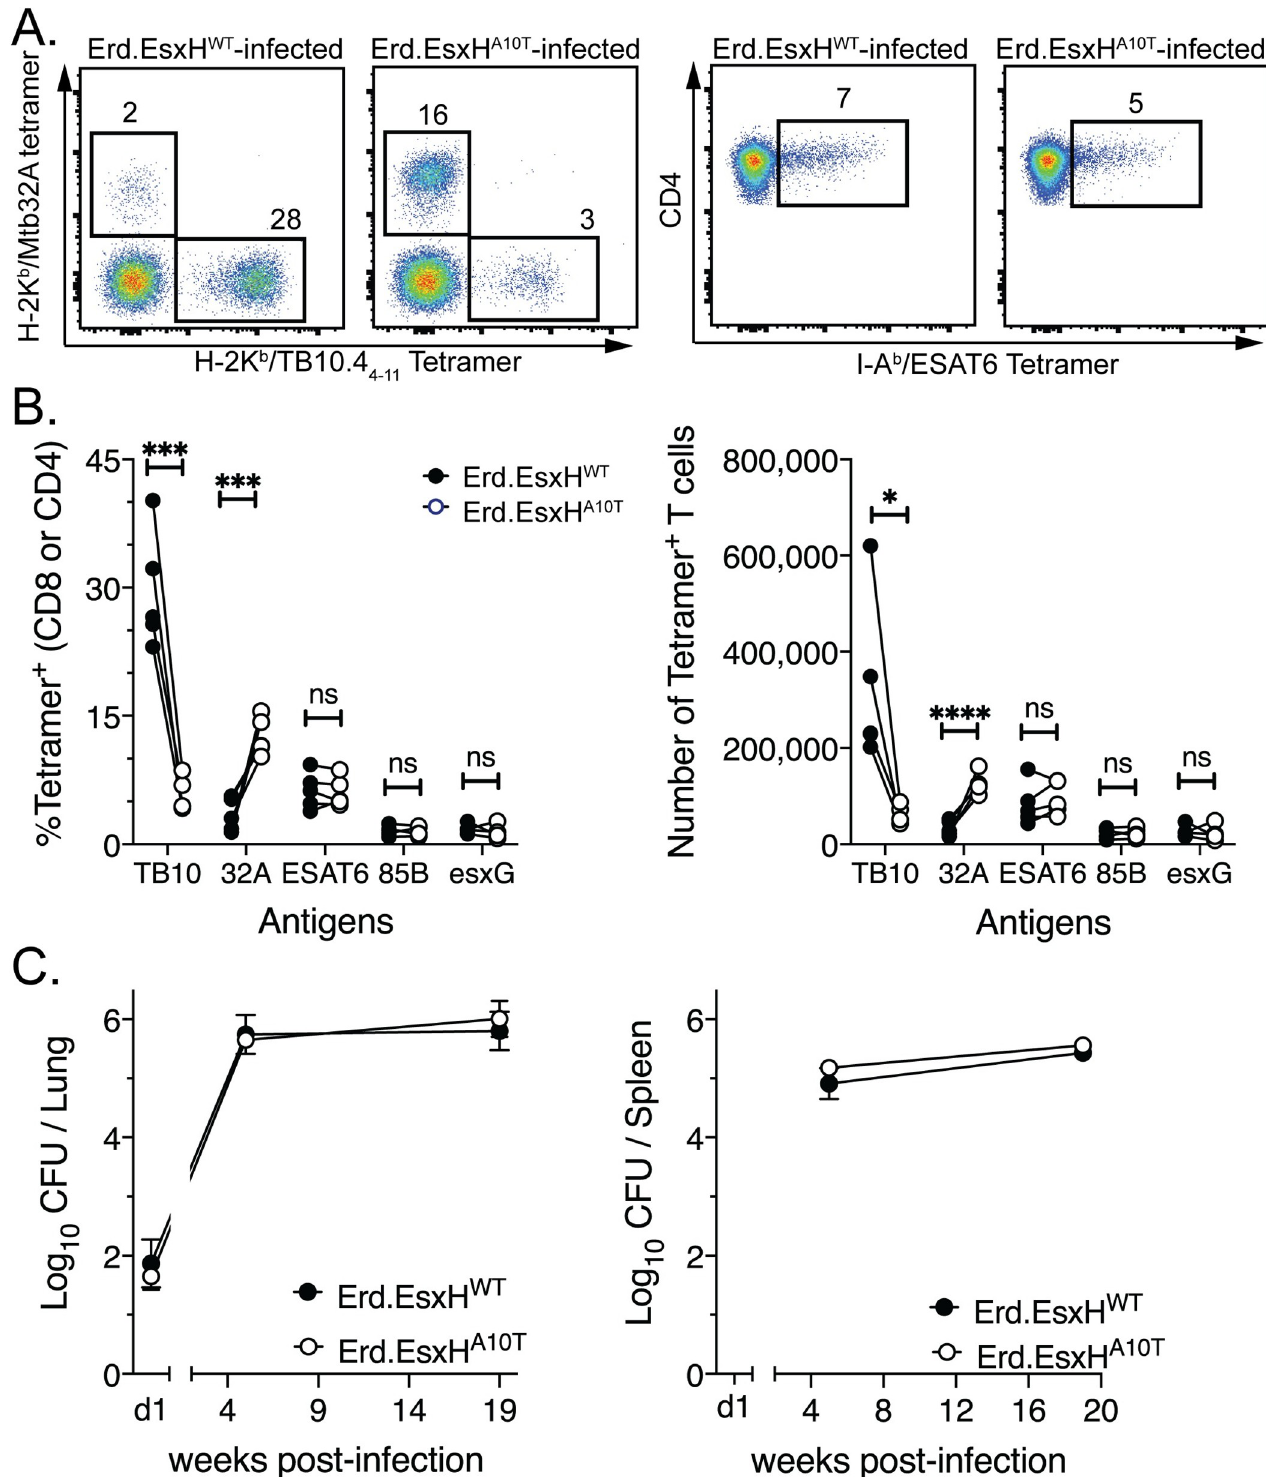
Fig 4. The A10T polymorphism leads to a change in immunodominance of the CD8 T cell response after 667 infection. C57BL/6J mice were infected with Erd.EsxH A10T or Erd.EsxH WT by the aerosol route and the lung T cell response was analyzed five weeks later by (A-B) tetramer staining and (C) the bacterial burden. (A) Representative flow cytometry plots of the frequency of MTB32a 309-318 - and TB10.4 4 -specific CD8 T cells (left), or ESAT6-specific CD4 T cells − 11 (right), after Erd.EsxH WT or Erd.EsxH A10T infection in the lungs of C57BL/6J mice. (B) The frequency and absolute number of antigen-specific T cells elicited